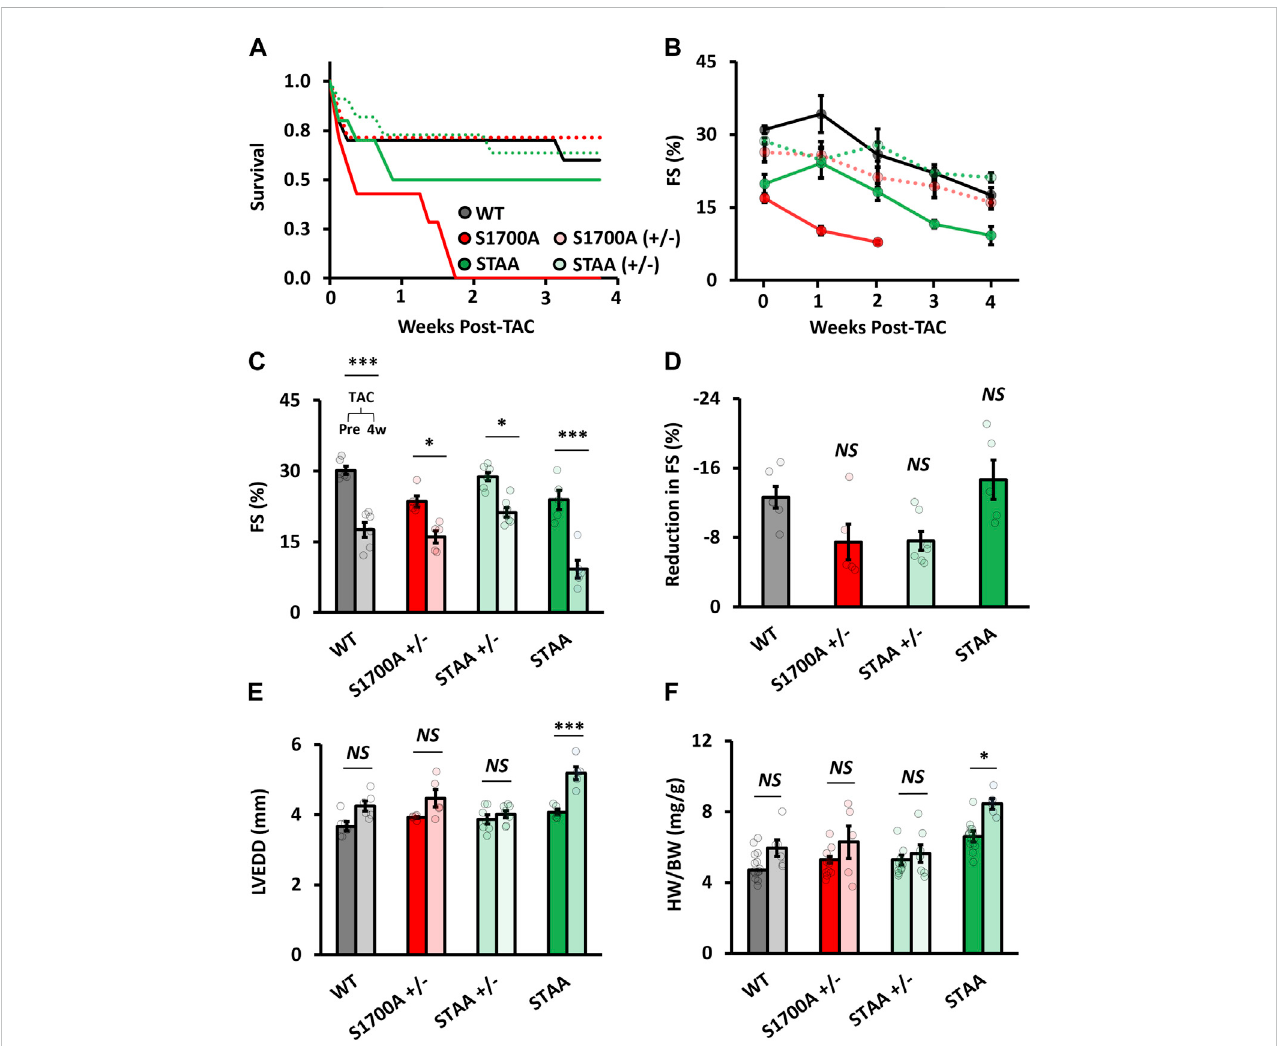
FIGURE 4 HypertrophyandventriculardilationafterTACinmicewithhomozygousmutationsofCa V 1.2phosphoregulatorysites. (A) SurvivalratesafterTACforWT (gray markers), heterozygous SA (light red) and STAA (light green), and homozygous SA (red) and STAA (green) mice aged 50 – 90 days. Left-ventricular (B) fractional shortening measured at 1 week intervals following TAC surgery. (C) Fractional shortening, (D) reduction in fractional shortening, (E) left-ventricular end-diastolic diameter, and (F) heart-weight 4 weeks after TAC surgery (right bars) and in non-TAC control animals (left bars) in WT and homozygous STAA mice. Error bars are S.E.M.; N 4 Weeks = 6 (WT), 5 (STAA), 7 (STAA +/ − ), 5 (S1700A +/ − ). * p < 0.05, ** p < 0.01, *** p <